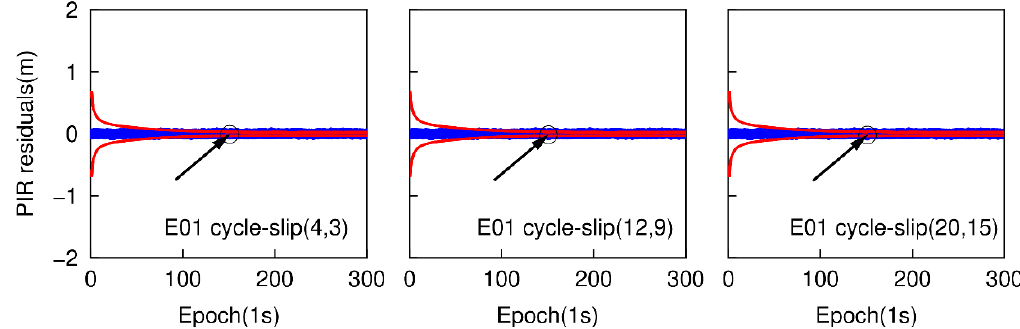
Figure 12. Specific small cycle-slip combination detection results with PIR combination for E01.